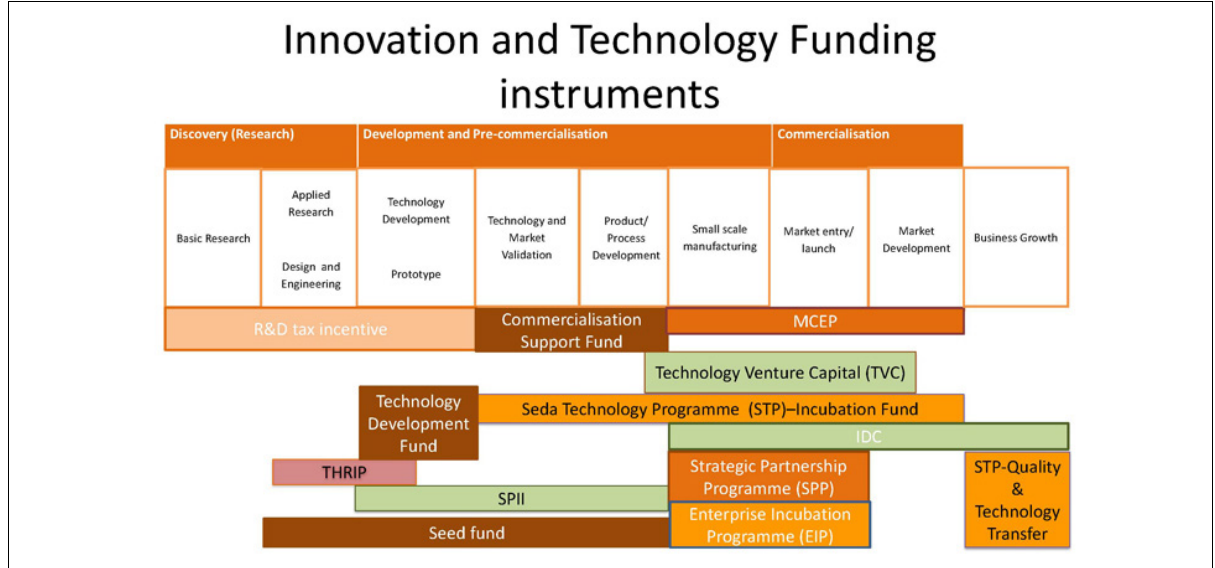
Figure 1: Innovation and technology funding